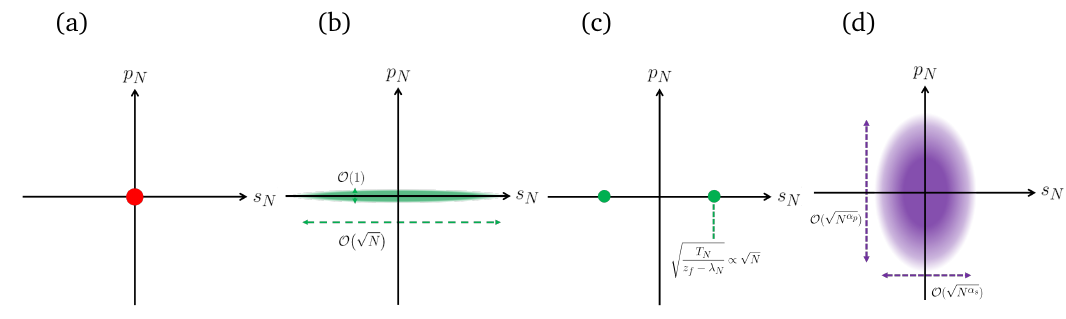
and p dependencies with N . The colour code N N